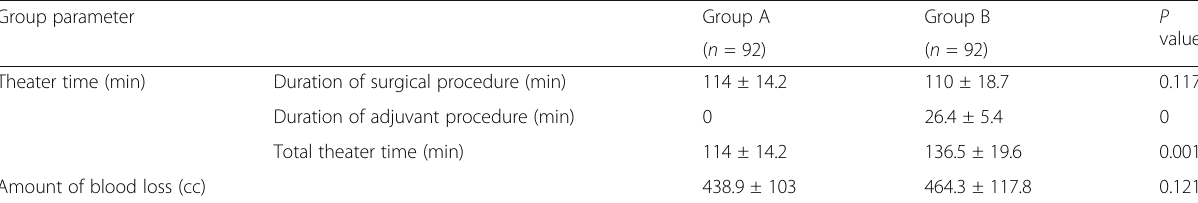
Table 3 Operative data of studied patients Group